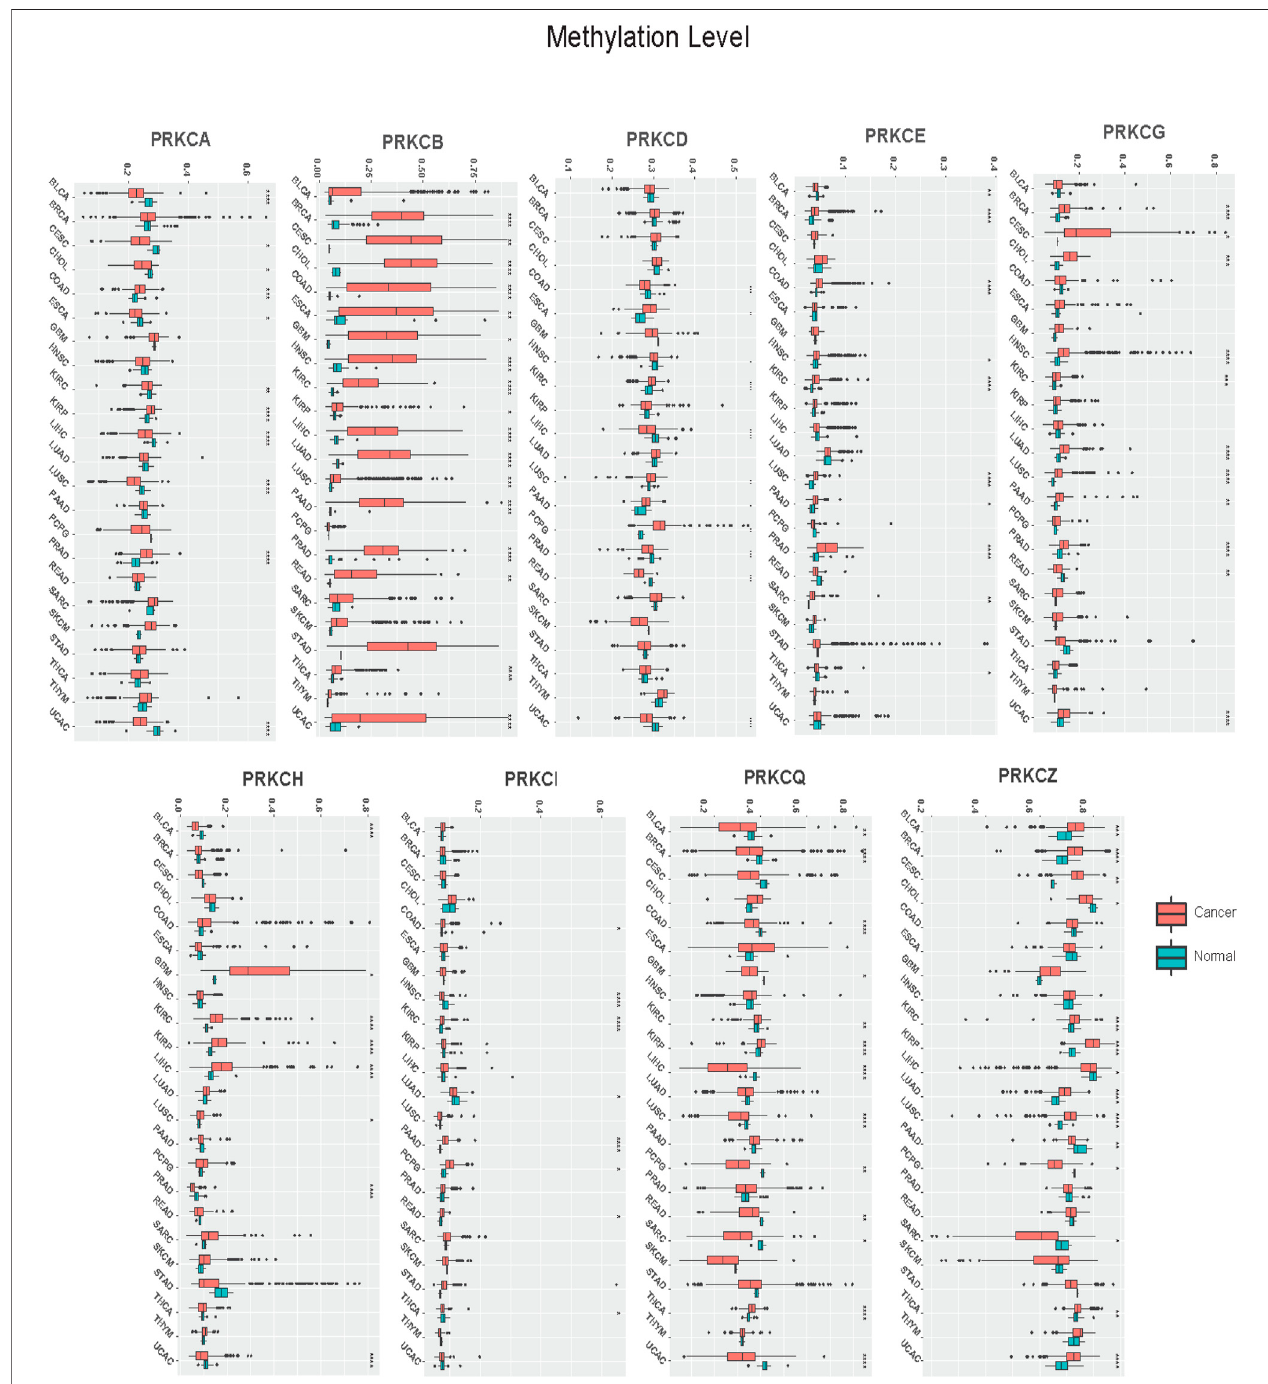
FIGURE 2 | Pan-cancer analysis of PKC genes methylation levels between Cancer and Normal tissues. *: p -value < 0.05; **: p -value < 0.01; ***: p -value < 0.001.